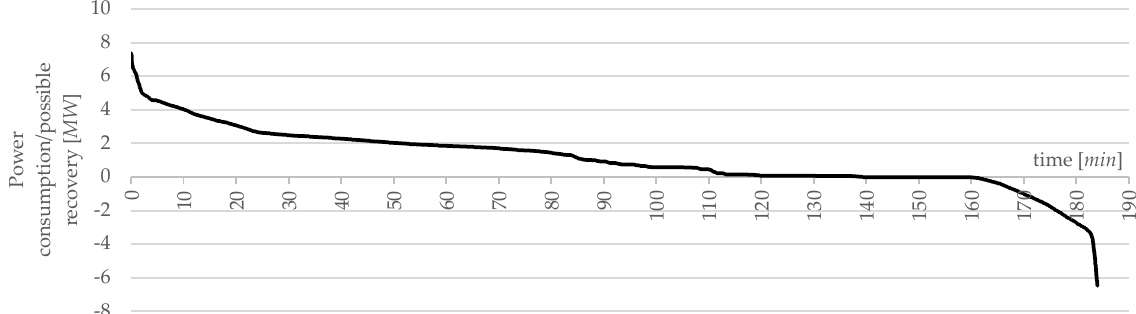
Figure 4. Extract from the results obtained for the timetable simulation in the variant before recon- figuration.